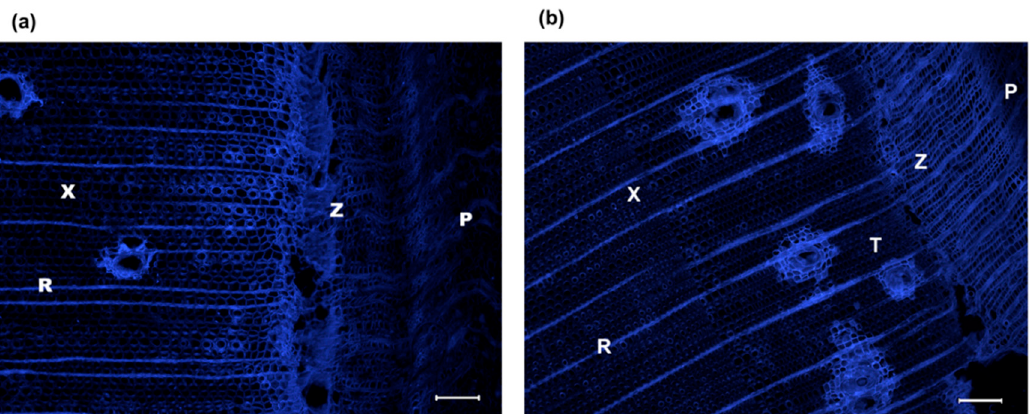
Figure 4. Transverse section of ( a ) non-inoculated control and ( b ) O. minus inoculated P. strobus stem stained with calcofluor at 65 dpi. Tangential rows of induced traumatic resin ducts are observed in the xylem of inoculated trees. Abbreviations : P, phloem; T, traumatic resin ducts; R, ray cells; X, xylem; Z, cambial zone. Magnification 5 × . Scale bar 100 m.